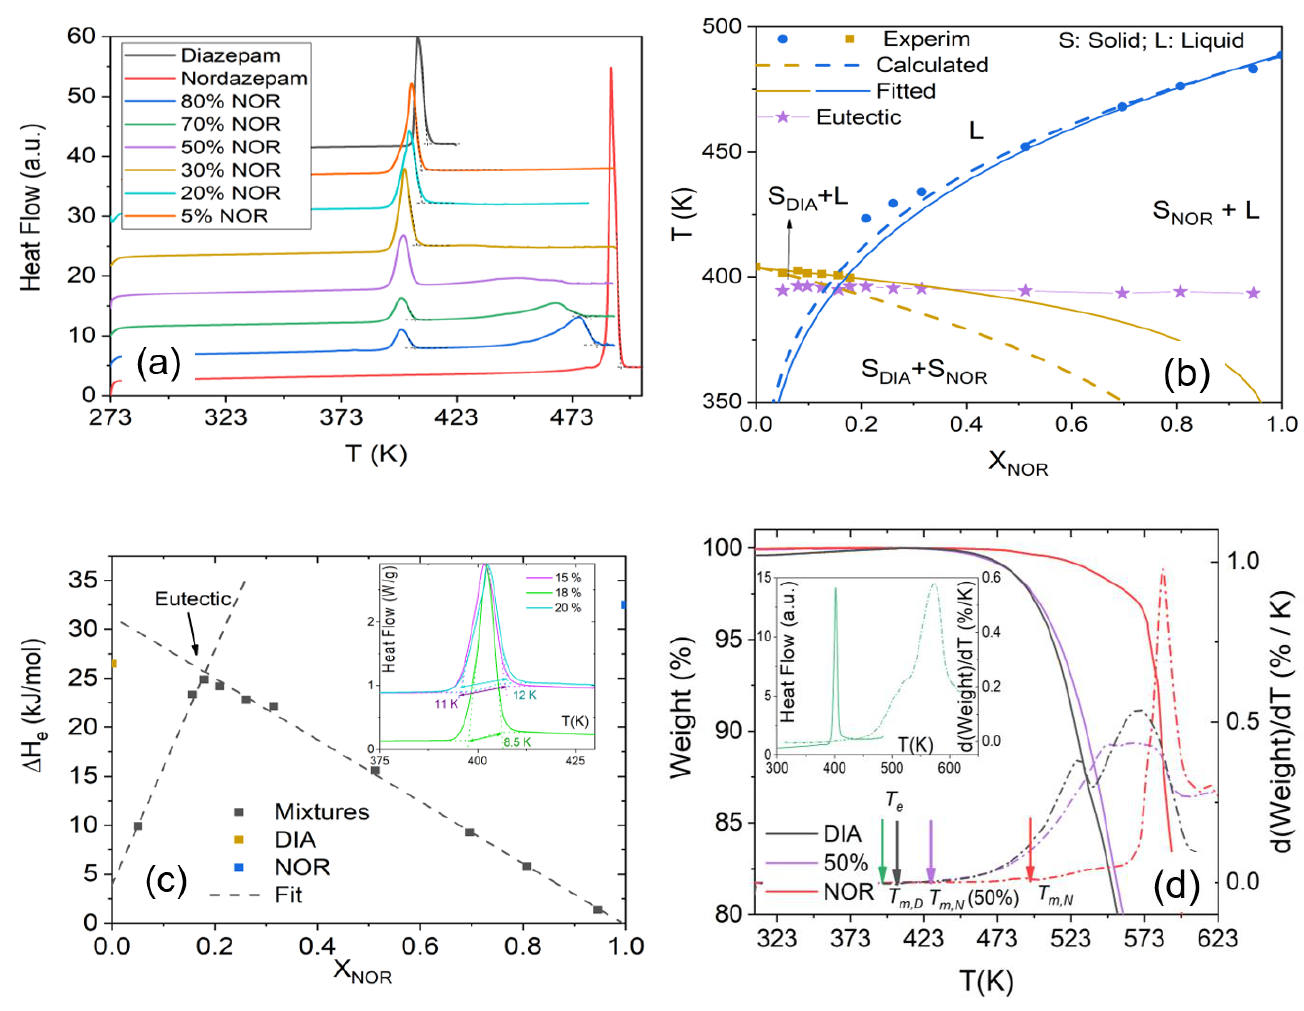
Figure 1. ( a ) First heating DSC traces of DIA, NOR, and their binary mixtures at distinct molar fractions, where the eutectic peak, as well as melting peaks corresponding to the phase separated components, can be observed. ( b ) Equilibrium-phase diagram, as a function of NOR molar fraction, for the binary system composed of DIA and NOR. The panel shows experimental data from DSC measurements (solid markers), the predicted liquidus temperatures with the Schröder–van Laar–Le Chatelier Equation (4) (dashed lines), and guides to eye which are fits of the experimental points with an equation linear in 1/ T (continuous line). ( c ) Eutectic melting enthalpy as a function of NOR molar fraction (Tammann diagram). The arrow indicates the eutectic concentration. Lines are a guide to the eye. Inset: Comparison of melting peaks for the mixtures with NOR molar fraction x = 0.15, x = 0.18, and x = 0.20. ( d ) TGA curves of pure NOR and DIA, and of the equimolar mixture. Arrows indicate the onset melting point of all three samples. Inset: DSC (continuous line) and TGA (dashed line) traces of the eutectic mechanical